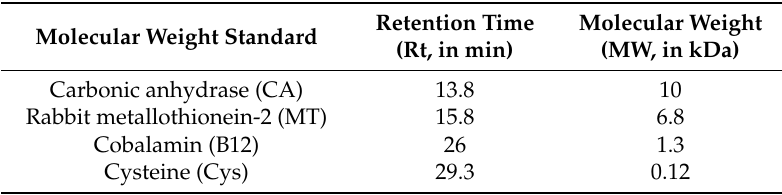
Table 1. Retention times (Rt) and molecular weight (MW) of four standards used for calibration of the Superdex peptide